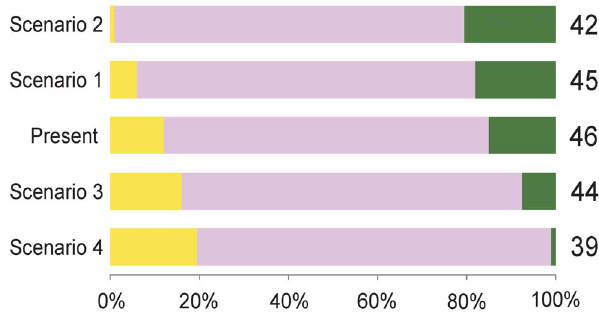
Figure 5. Current and projected number of bird species using the countryside-SAR under four land-use scenarios. Bars show the representation of each land-use in the Castro Laboreiro Valley for four scenarios of land-use change. For each scenario the number of bird species is given as projected by the countryside-SAR model: farmland (yellow), shrubland (rose) and oak forest